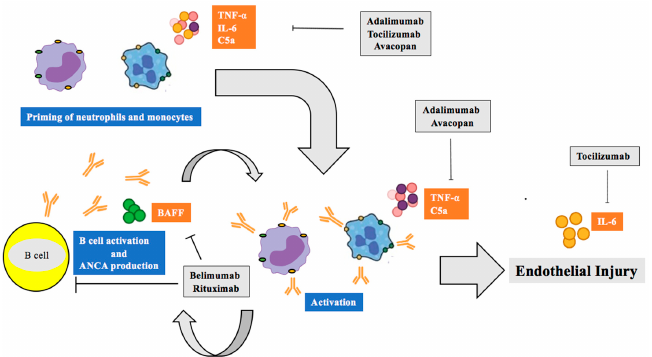
Figure 3. Therapeutic armamentarium of ANCA-associated vasculitis based on disease pathogenesis. TNF- α , IL-6, and alternative complement activation contribute to neutrophil priming, activation, and endothelial injury and are targeted by adalimumab, tocilizumab, and avacopan, respectively. BAFF stimulates B cell activation and is targeted by belimumab. B cells are targeted by rituximab.